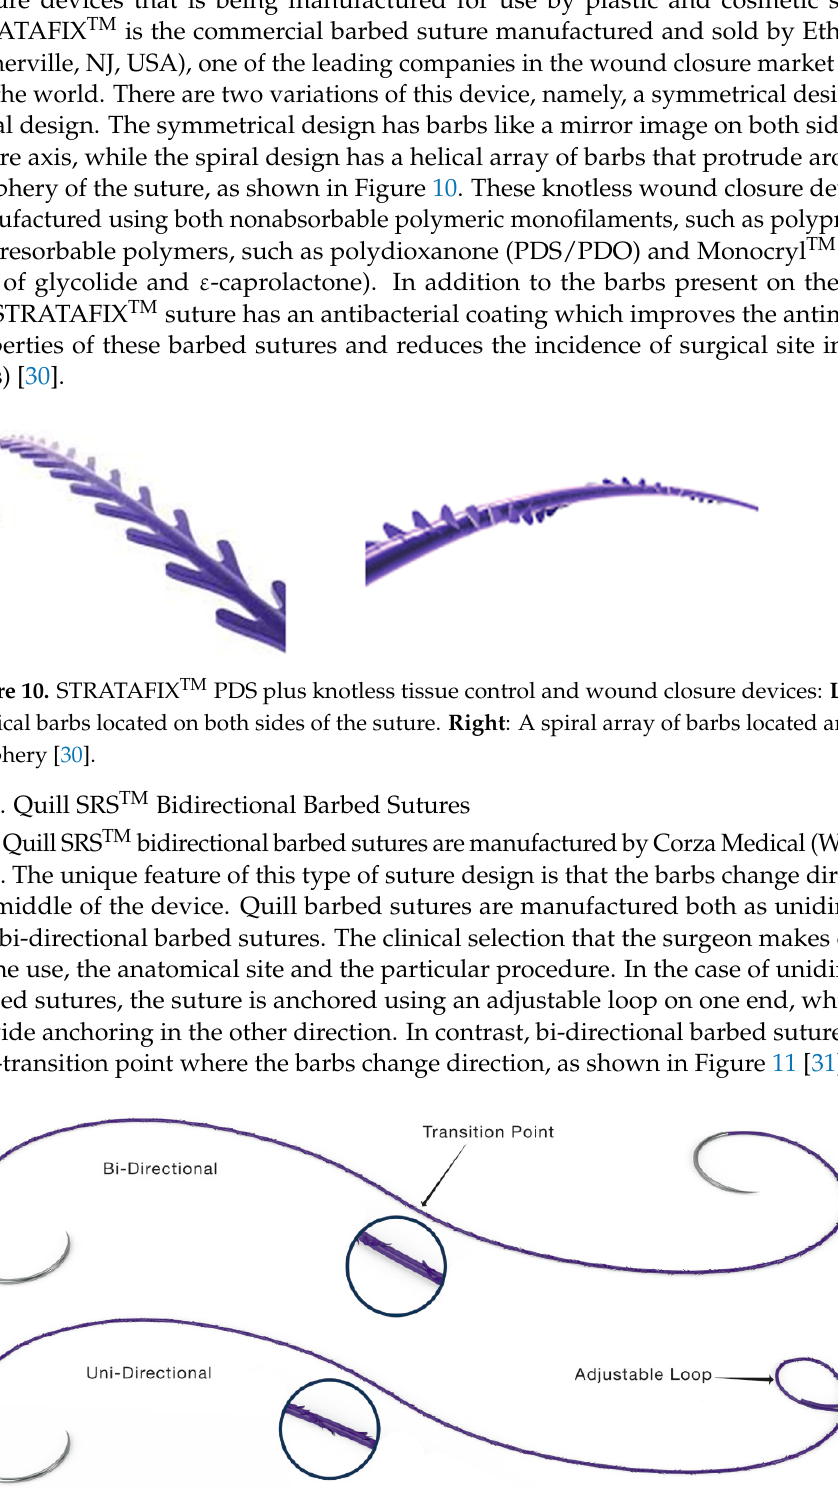
Figure 11. Top: Quill TM bi-directional barbed suture. Bottom: Quill TM unidirectional barbed suture [31].